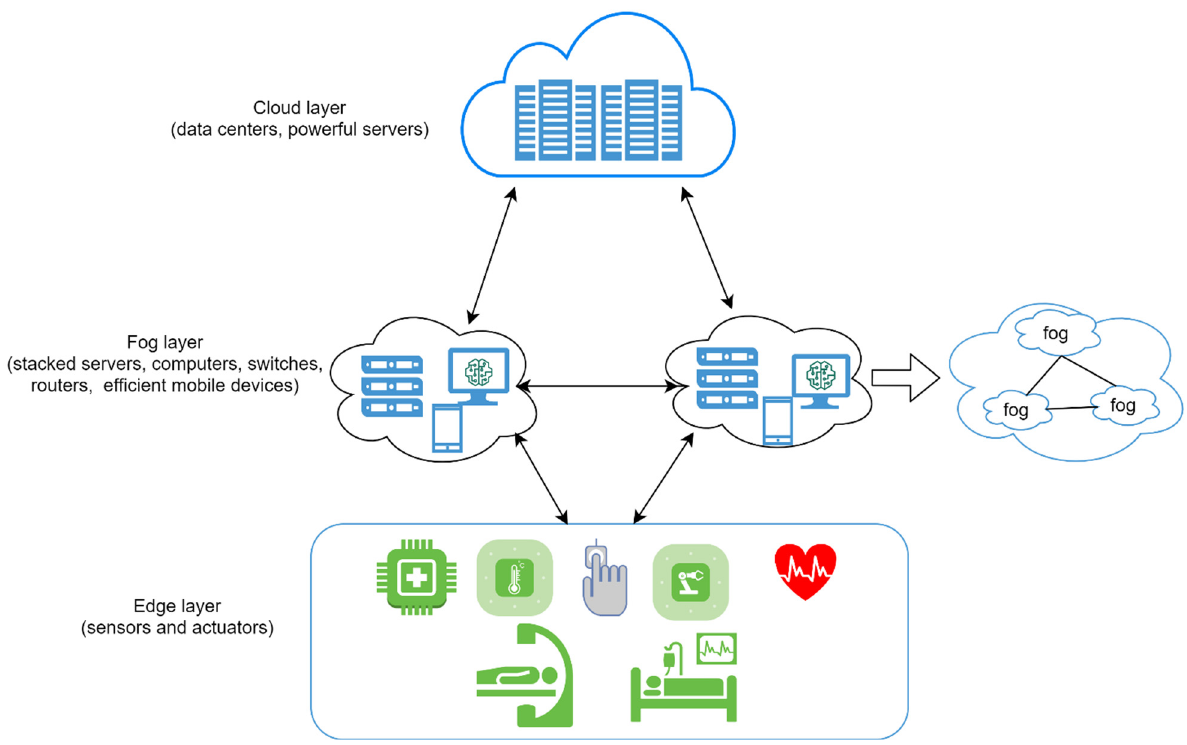
Figure 1. The proposed architecture of fog computing-based medical IoT is inspired by the IEEE standard [48] .